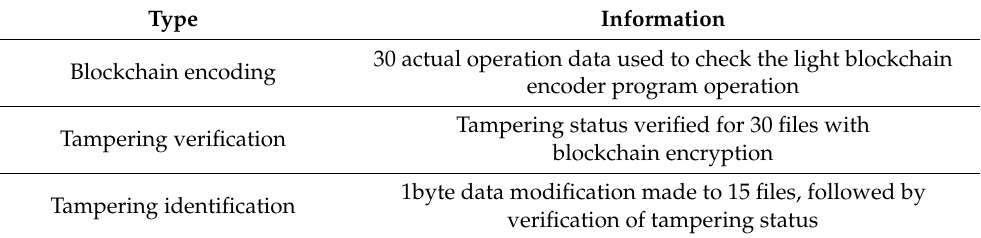
Table 6. Performance analysis